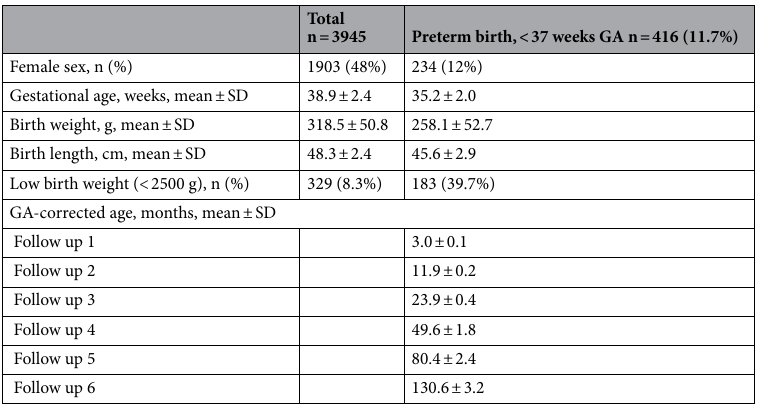
Table 1. Characteristics of participants from the 2004 Pelotas Birth cohort included in this analysis, 2004– 2015. GA gestational age, SD standard deviation.